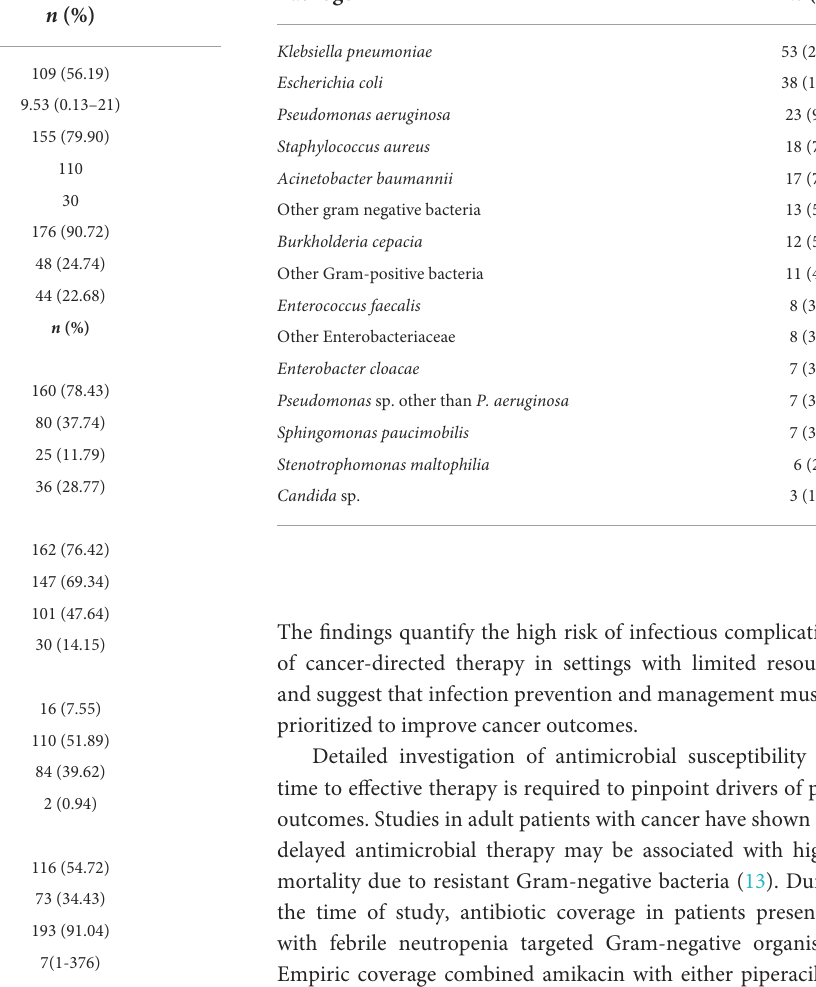
TABLE 2 Pathogens isolated from bloodstream infections ( N =